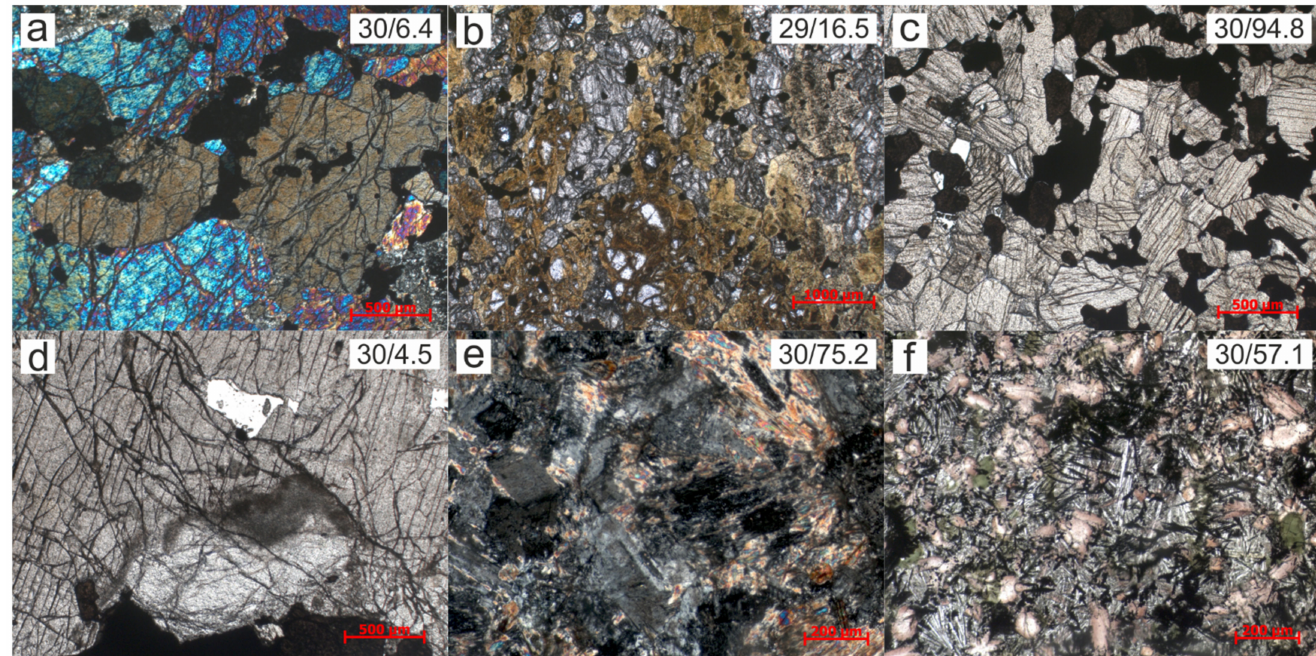
Figure 11. Rock photographs taken by microscope: ( a ) olivinites (nicols crossed); ( b )—banded wehrlite (parallel nicols); ( c ) ore pyroxenites (parallel nicols); ( d ) kugdite (parallel nicols); ( e ) nordmarkite (nicols crossed); ( f ) alkaline picrite (parallel